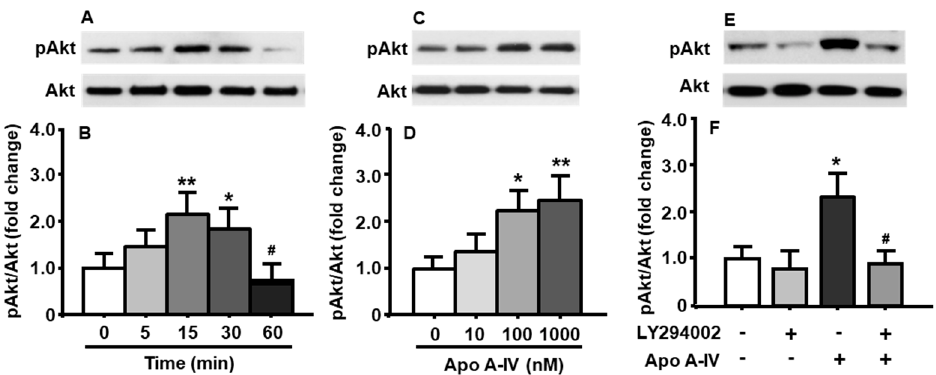
Figure 3. ApoA-IV activated PI3K / Akt signaling pathway in cultured neuronal cells. ApoA-IV (100 nM) time-dependently increased the phosphorylation of Akt ( A , B ). When treated for 15 min, apoA-IV concentration-dependently increased the ratio of pAkt / total Akt ( C , D ). This e ff ect was significantly attenuated by LY294002 (10 µ M) ( E , F ). Mean ± S.E., n = 3–4. * p < 0.05, ** p < 0.01, compared to pAkt level at 0 min or vehicle control. # p < 0.05, compared to that in neuronal cells treated with apoA-IV for 15 min ( B ) and ApoA-IV treated alone ( F ), respectively.